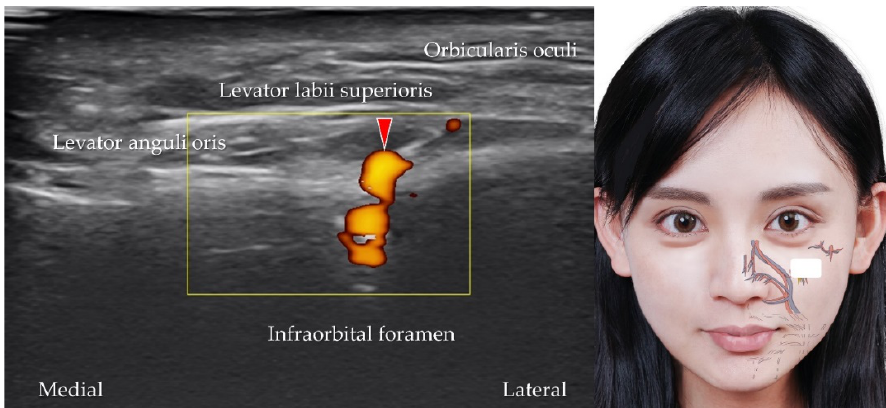
Figure 12. Power Doppler ultrasound imaging of the infraorbital artery (red arrowhead) . White square , footprint of the ultrasound transducer.